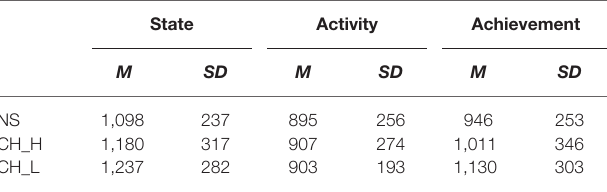
TABLE 6 | Mean and SD reaction times (ms) for progressive